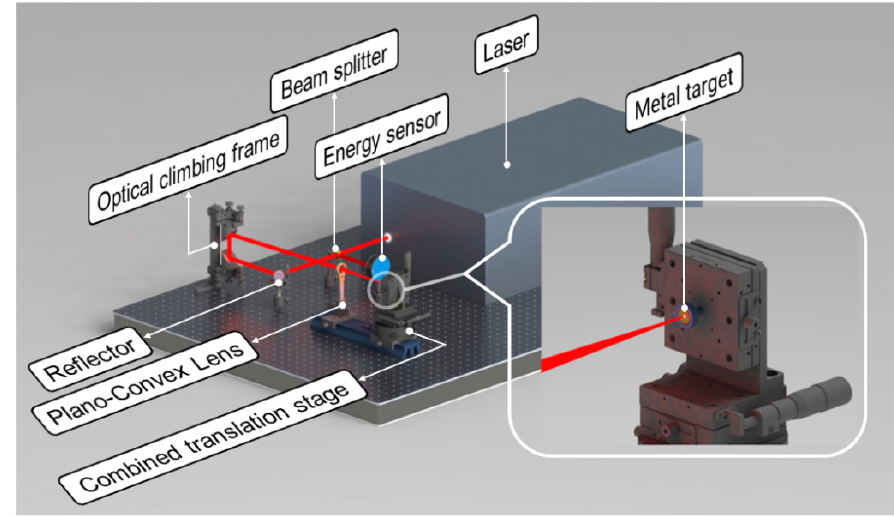
Figure 1. Schematic diagram of the laser ablation experimental setup. Table 1. Laser parameters in the experiment.